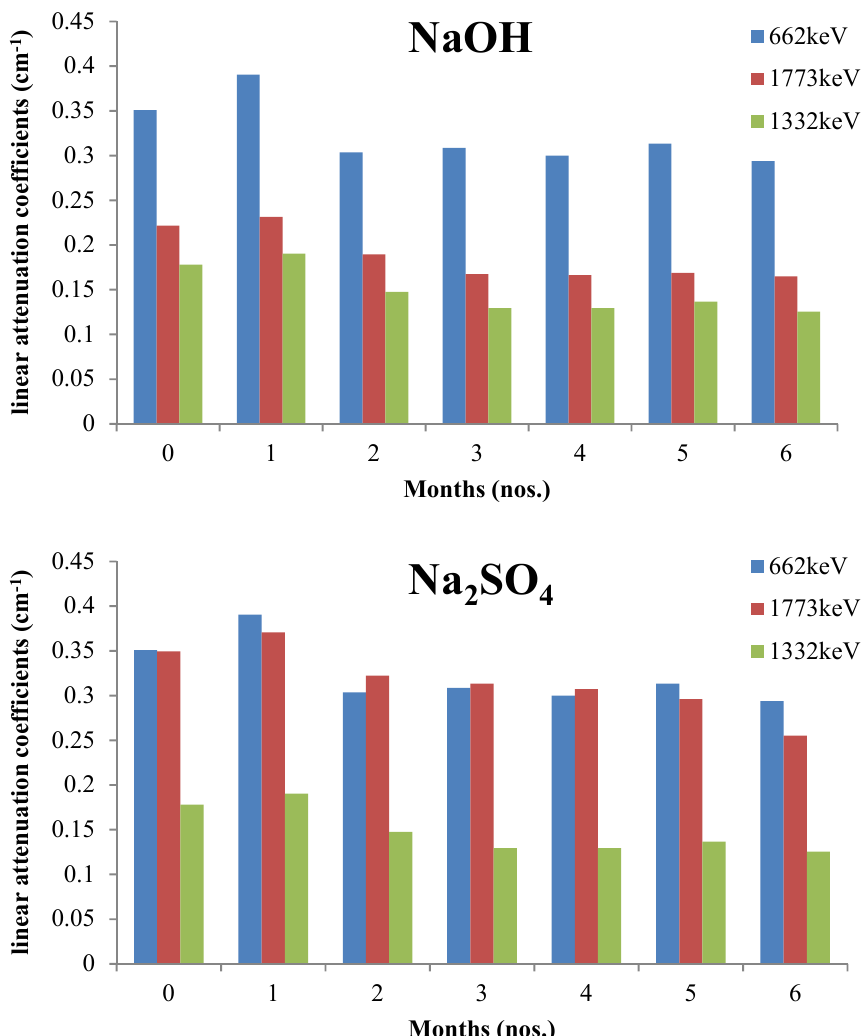
Figure 19. Variation of linear attenuation coefficients with distinct chemical environments at 662, 1332, and 1773 keV energies (adapted with improvement from [207]).